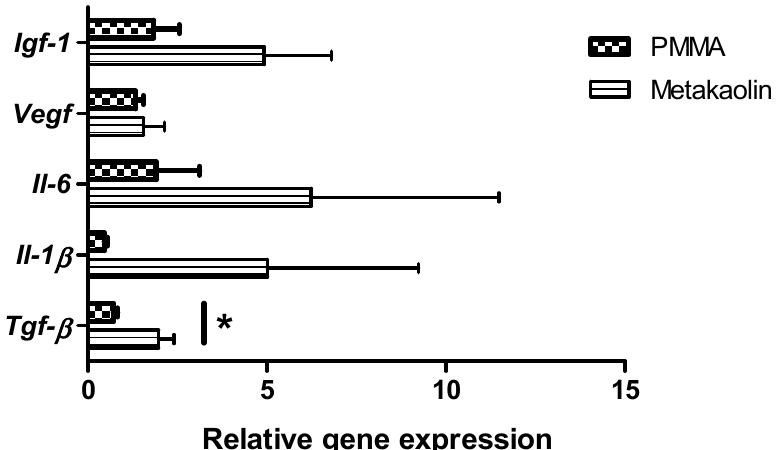
Figure 3. Relative levels of Igf-1 , Vegf , Il-6 , Il-1 β and Tgf- β mRNA in four-week-old PMMA-IMs or metakaolin-IMs. Data are expressed as the mean ± SEM, * p < 0.05.